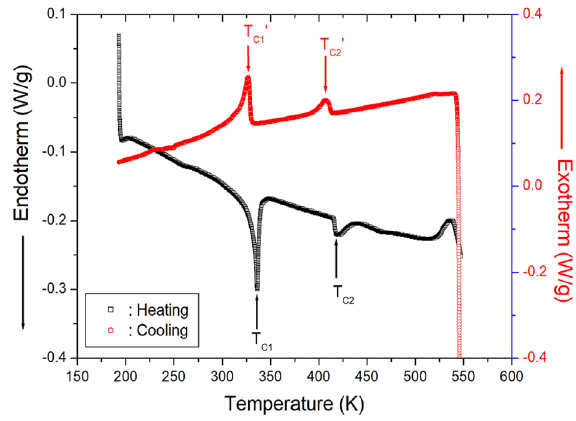
Figure 2. DSC curves of [NH 3 (CH 2 ) 5 NH 3 ]CdCl 4 during heating and cooling.